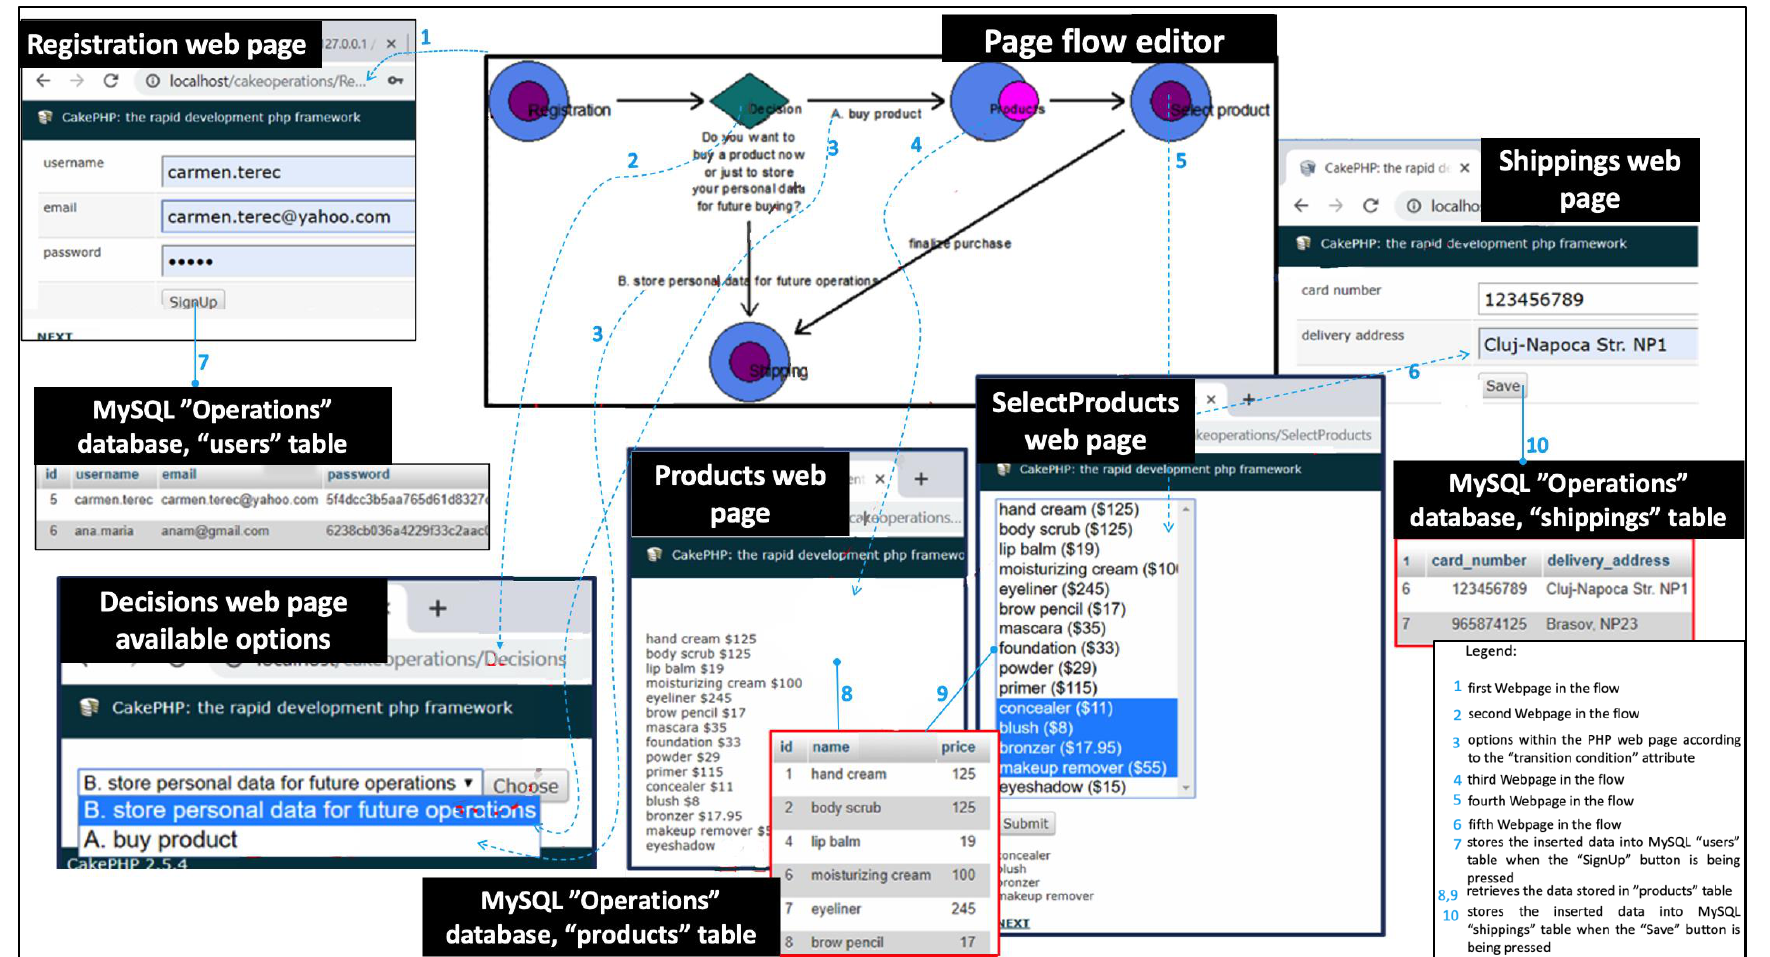
Figure 9. Operations mapped on associated PHP